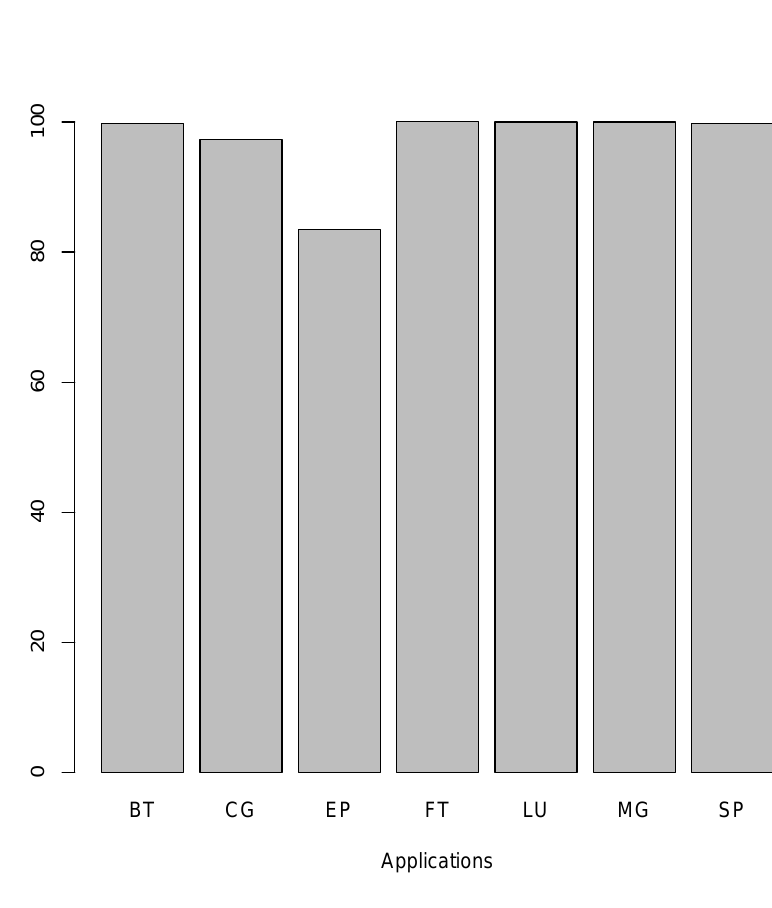
Figure 5: The performance of application optimisations using GB-GP- Parallelisation